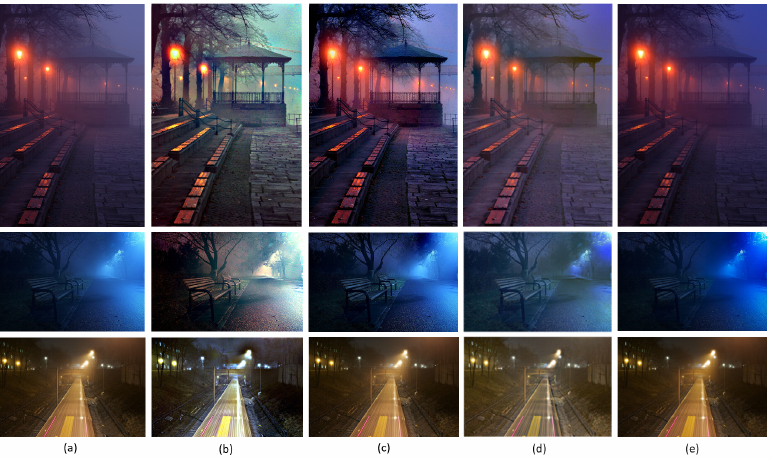
Figure 16. Comparison on nighttime images from [33]: ( a ) foggy images, ( b ) Li et al. [31], ( c ) Yu et al. [42], ( d ) color version (C), ( e ) white version (W).